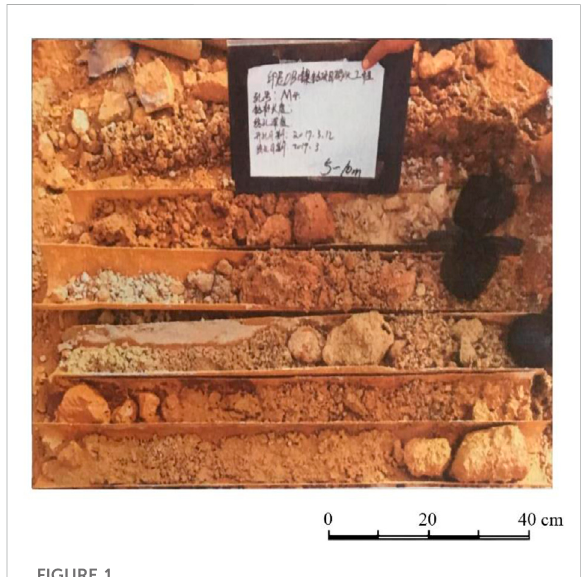
FIGURE 1 Image of coral sands at a nickel-cobalt ore port in